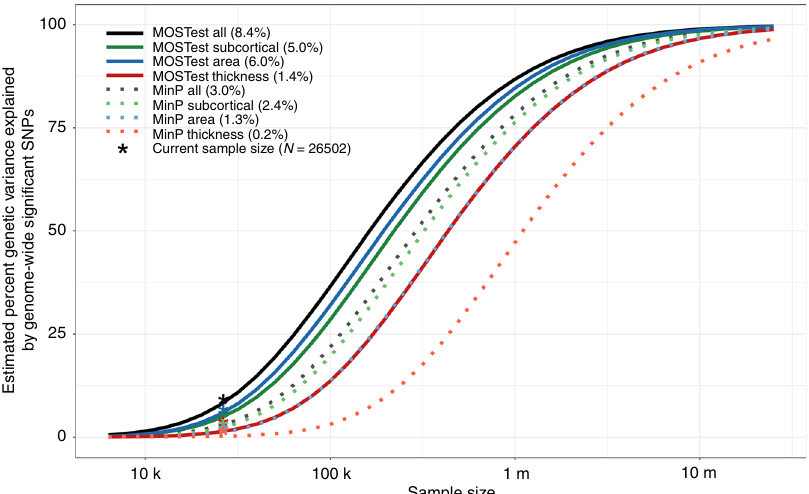
Results from the replication of the genome-wide signi fi cant loci are identi fi ed through MOSTest and min-P in an additional sample of 4884 individuals. The column “ # loci replicated ” indicates the amount of discovered loci in the main analysis that surpass a nominal signi fi cance ( p = 0.05) in the replication sample. The “ fraction replicated ” column divides the number of loci discovered in the main analysis with the number of loci that replicated.